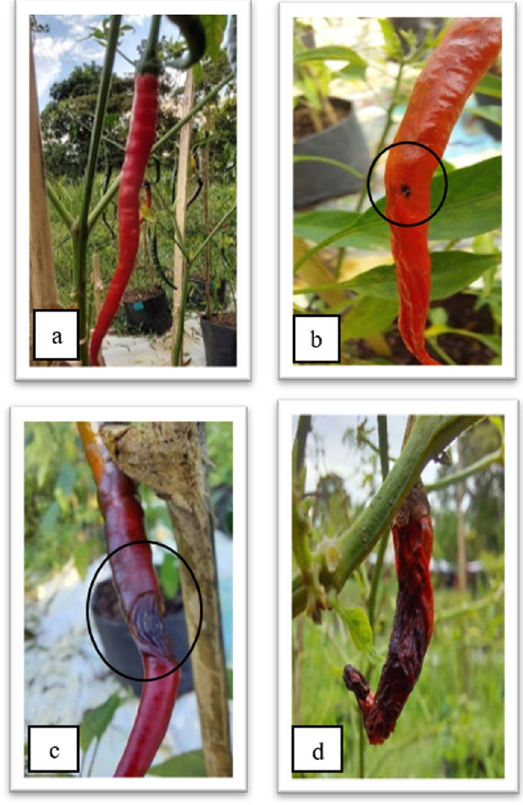
Fig. 1 The severity of anthracnose symptoms on chili fruits. a Chili fruit without anthracnose symptoms. b Initial symptoms of blackish brown spots on chili fruits. c The spots extend to form concentric indentations. d The spots spread to all parts of the chili